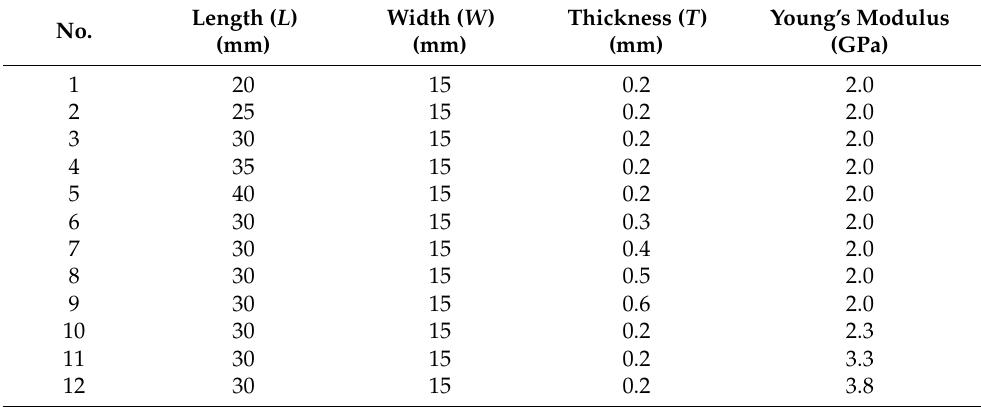
Table 1. Structural and material parameters of 12 anemometer